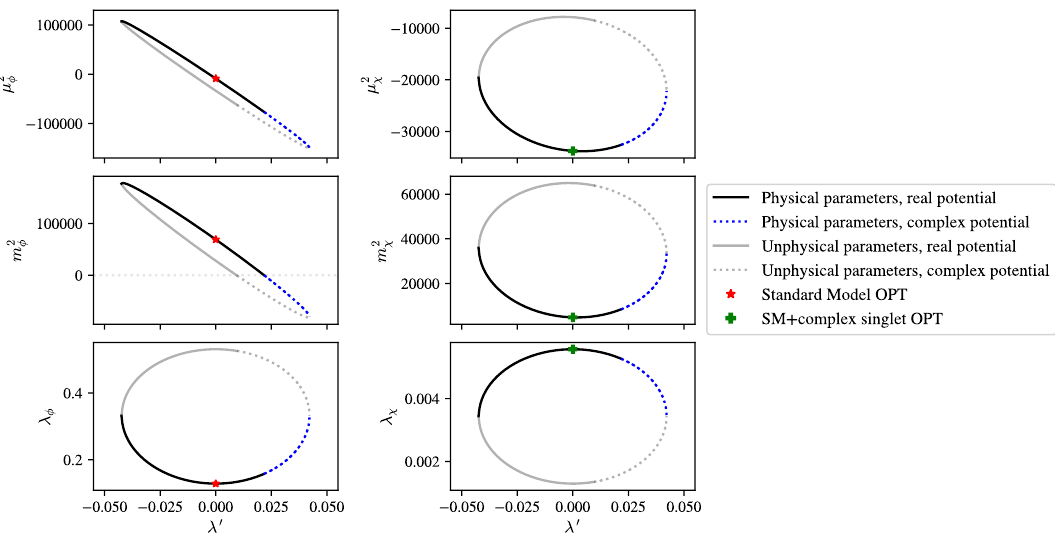
Figure 2 . Parametrization of the singlet extended SM for M s = 260 GeV , w 0 = 10 v 0 , and regularization scale Q = M t . The circular shapes indicate the possible real solutions to the parametrization conditions. The unphysical solutions are shown in light gray. The blue dotted part of the physical parameters corresponds to solutions where the effective potential becomes complex for some region satisfying v < v 0 and w < w 0 , but the minimum remains real. Additionally, at λ 0 = 0 the SM sector and the singlet are completely decoupled, and they can be parametrized separately (as in section 2.2), leading to the points shown with red stars and green